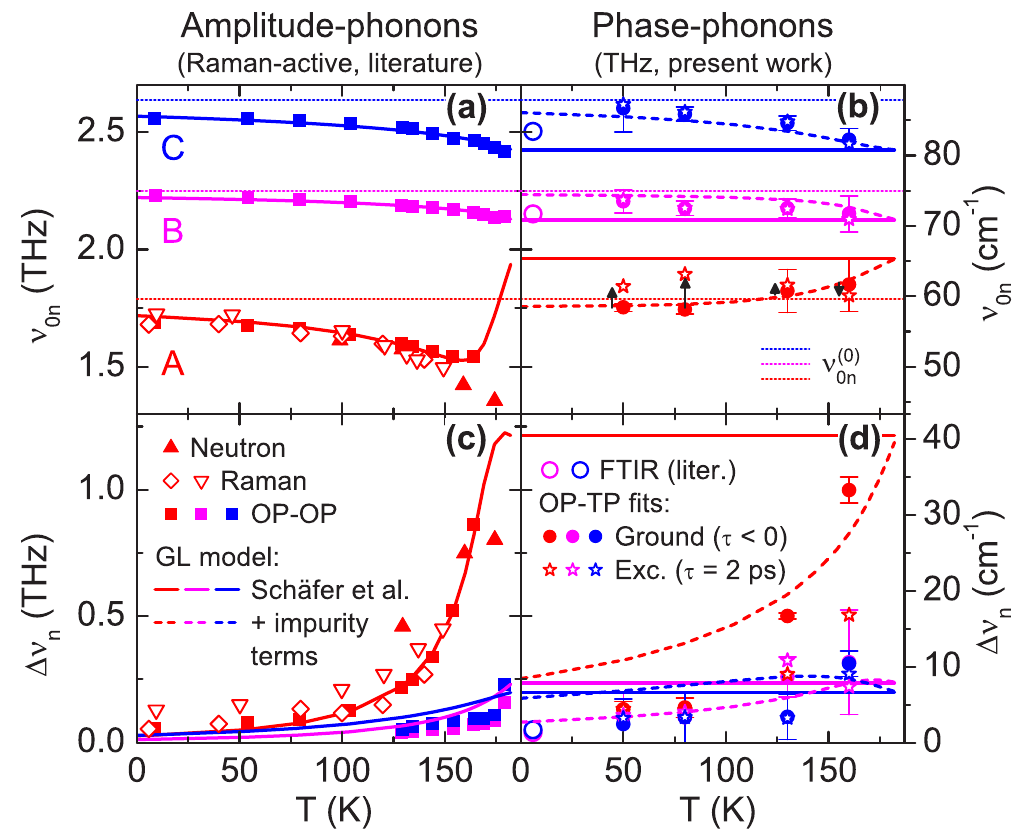
Figure 5. Temperature dependence of amplitude- and phase-phonon band parameters. Amplitude- (left graphs) and phase-phonons (right) for T < T c ; center frequencies ν 0 n (top graphs) and bandwidths Δ ν n (FWHM, bottom), for bands n = A (red), B (magenta) and C (blue). Literature data from neutron scattering (  23 ), Raman scattering ( {\triangledown} 24 ; ◊ 25 ), optical-pump optical-probe reflectivity (  11, 12 ), and far-infrared FTIR measurements ( ○ 10 , T = 6 K). THz TDS data (present work) from global analysis of OP-TP data (for T = 50, 80, 130 and 160 K) for both GS ( ● ) and τ = 2 ps after excitation ( ☆ ), including confidence intervals for the GS parameters. Also included are model curves from the TDGL model, with parameters fit to the amplitude phonons in ref. 11, both without (solid) and with (dashed) pinning/scattering contributions from impurities (with Ω i (0)/2 π = 9.3 THz and g i = 1.9, see text; note that this only affects the predictions for the phase channel, so both curves are superposed for the amplitude